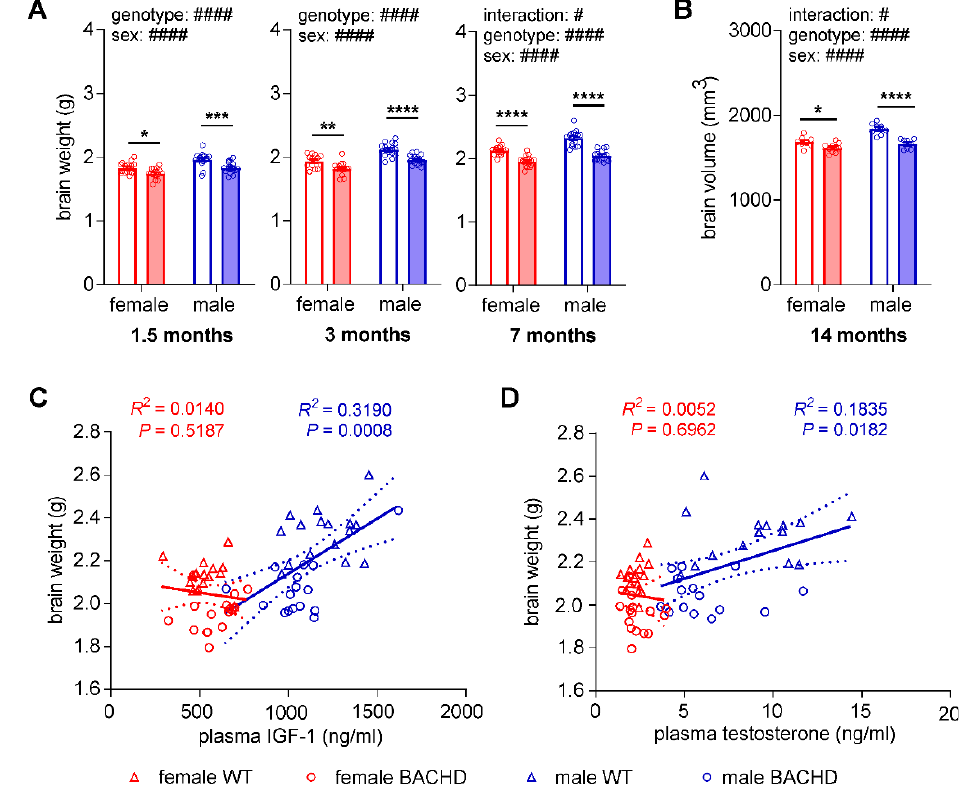
Figure 4. Sex-differences in brain weight and volume reductions and correlation of brain weight with plasma IGF-1 and testosterone levels in BACHD rats. ( A ) Brain weight in young (1.5 months), young adult (3 months) and middle-aged adult (7 months) ( n = 12–16/genotype/sex/age) groups. ( B ) Whole brain volume at 14 months of age ( n = 8 female WT, 8 male WT, 10 female BACHD, 8 male BACHD). ( C ) Correlation between plasma levels of IGF-1 and brain weight at 7 months of age in male and female rats. ( D ) Correlation between plasma levels of testosterone and brain weight at 7 months of age in male and female rats. In A and B: data are expressed as mean values ± SEM; statistical significance was determined by regular two-way-ANOVA followed by Sidak’s post-hoc test. # indicates the results of two-way-ANOVA analysis; * indicates the results of post-hoc test. #/* p ≤ 0.05; ** p ≤ 0.01; *** p ≤ 0.001; ####/**** p ≤ 0.0001. In C and D: data are expressed as individual values (circles and triangles) with media (central continuous line) and 95% confidence interval ranges (dashed lines); statistical significance was determined by regression